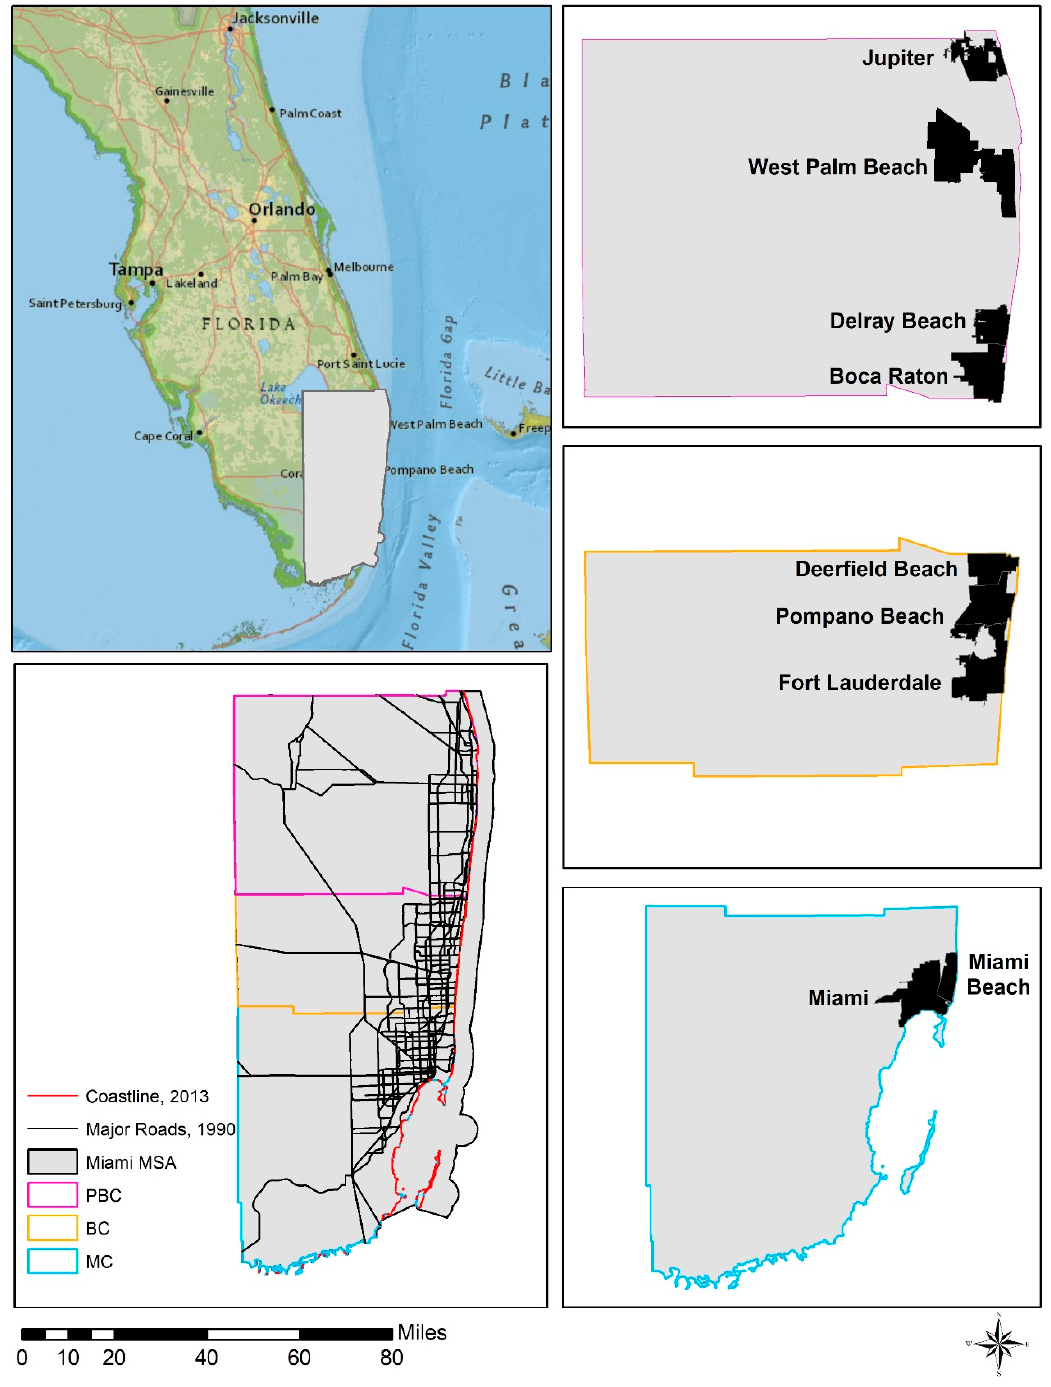
Figure 1. Location of the Florida Metropolitan Statistical Area (Miami MSA), three counties, major cities, along with coastline in 2013 and major roads in 1990 within the study area.